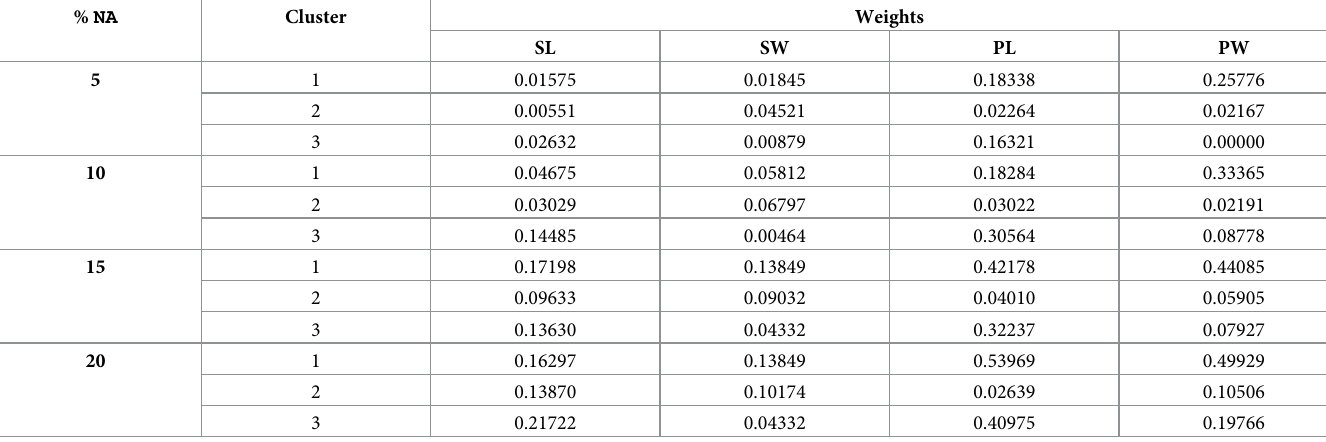
Table 14. Consistency of variables in the VKFCM-K-LP clustering with the imputation of missing values using median values for the Iris Plant dataset.